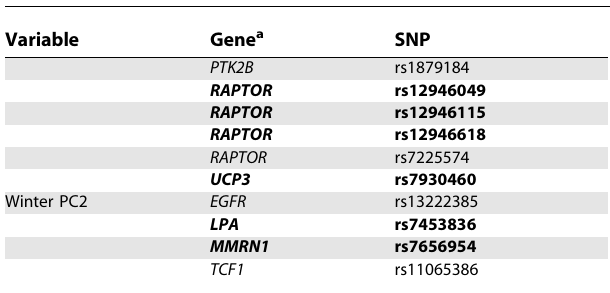
Table 2. SNPs Significant with Empirical p , 0.05 with